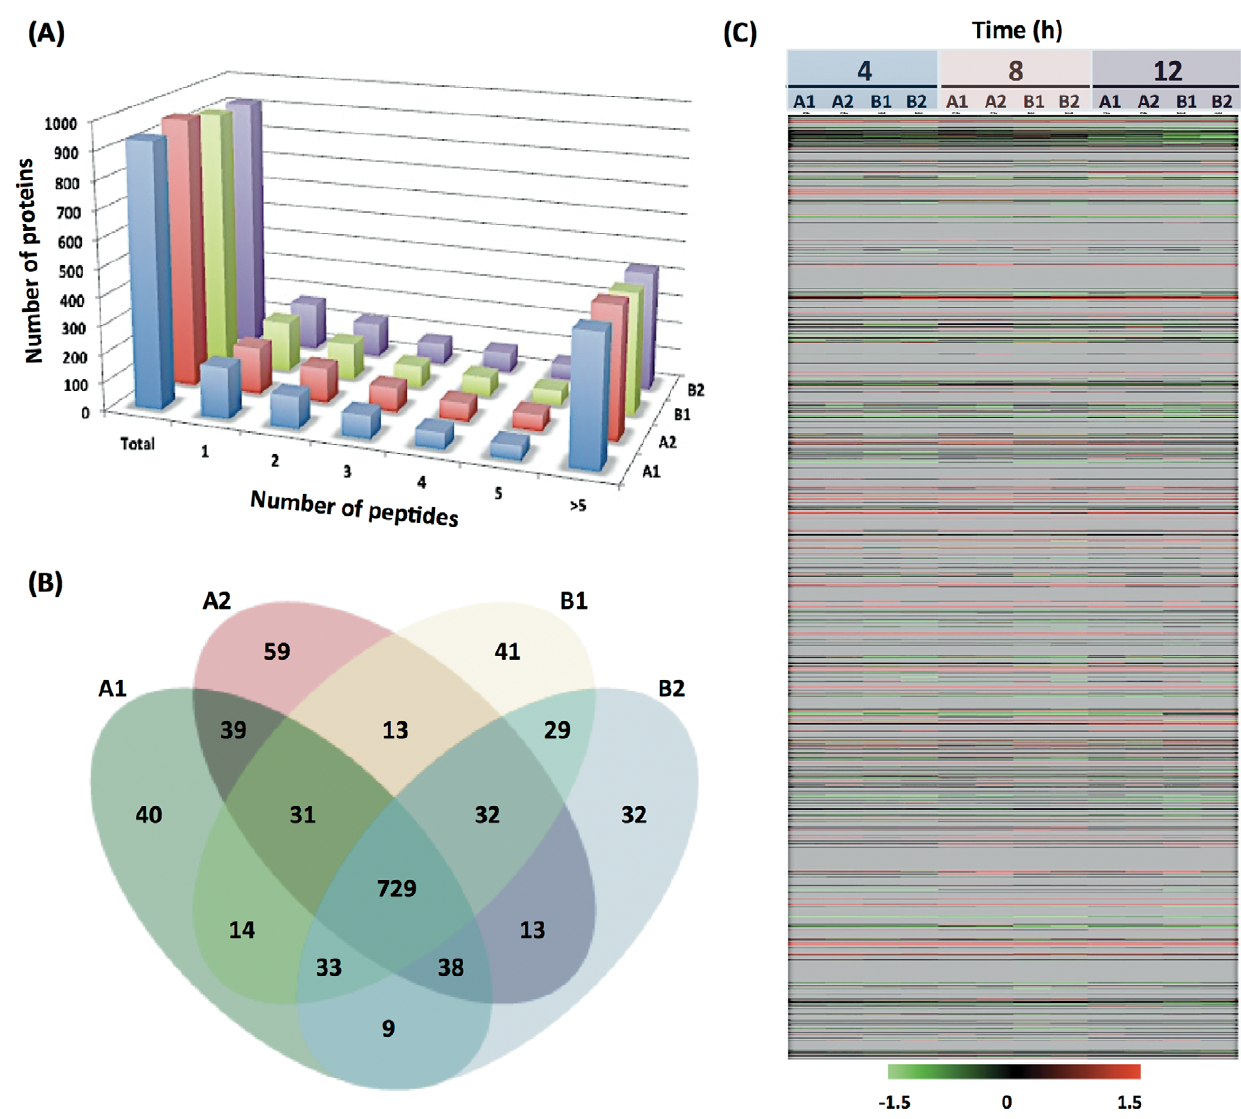
Figure 3. Overview of the iTRAQ results. (A) Number of distinct peptides identified in a protein. The peptides were identified using Mascot Daemon software with a 95% confidence level. About 17–19% of proteins were identified by single peptides. More than 80% of proteins were identified by at least two peptides. Approximately 47% of proteins were identified by more than 5 peptides. (B) Comparison of protein identification in iTRAQ experiments. Venn diagram shows the comparison of protein identification between biological replicates (A versus B) as well as technical replicates (A1 versus A2 and B1 versus B2). There were 207 proteins identified in a single experiment and 217 proteins identified in two or three of the experiments. A total of 728 proteins were identified in all four experiments. (C) Protein expression pattern in C. difficile following the in vivo incubation. Protein expression after 4, 8, and 12 h in vivo incubation is compared with that of ex vivo growth. Rank normalized data from biological and technical replicates were used to create a heatmap for C. difficile . The proteins were arranged according to the numbering of the C. difficile 630 coding sequences, with CD0001 at the top and CD3680 at the bottom, followed by proteins from the plasmid pCD630 (CDP01 to CDP11). Each column represents a particular time point in one iTRAQ experiment, and each row corresponds to a specific protein. The status of each protein is indicated by color as follows: red, induced; green, repressed; black, unchanged; and gray, undetected in our conditions.